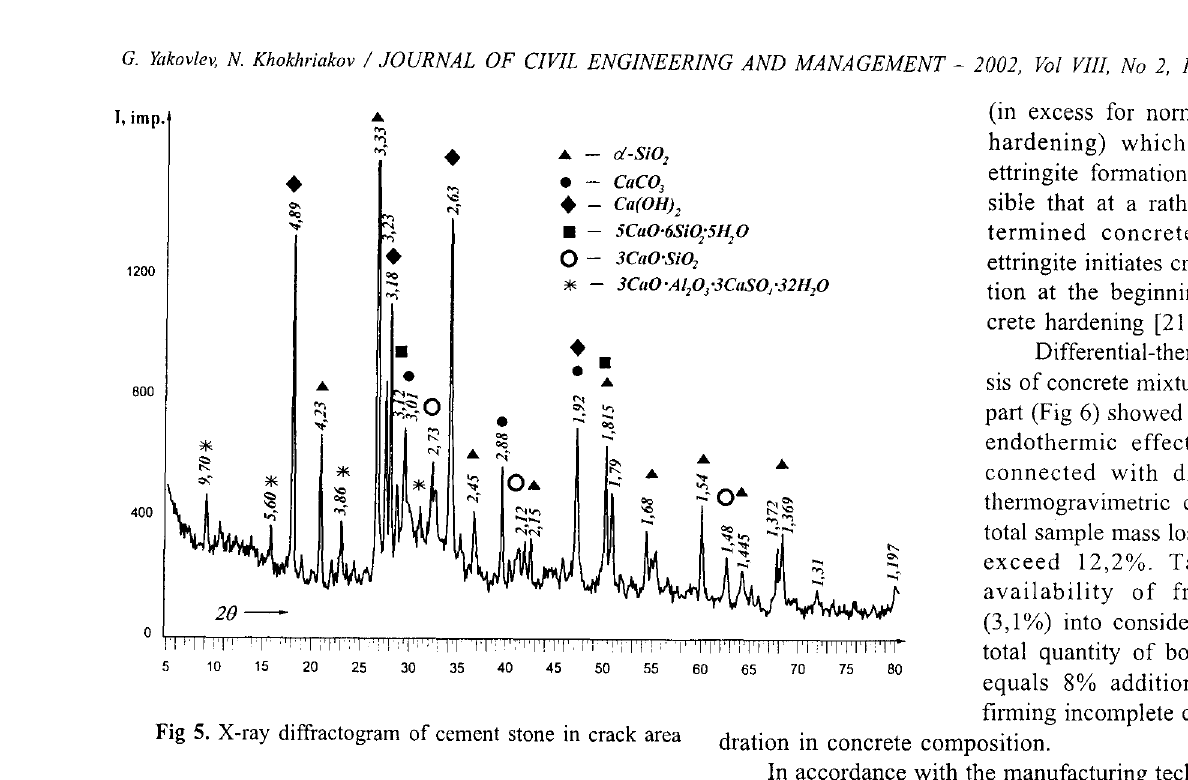
Fig 5. X-ray diffractogram of cement stone in crack area